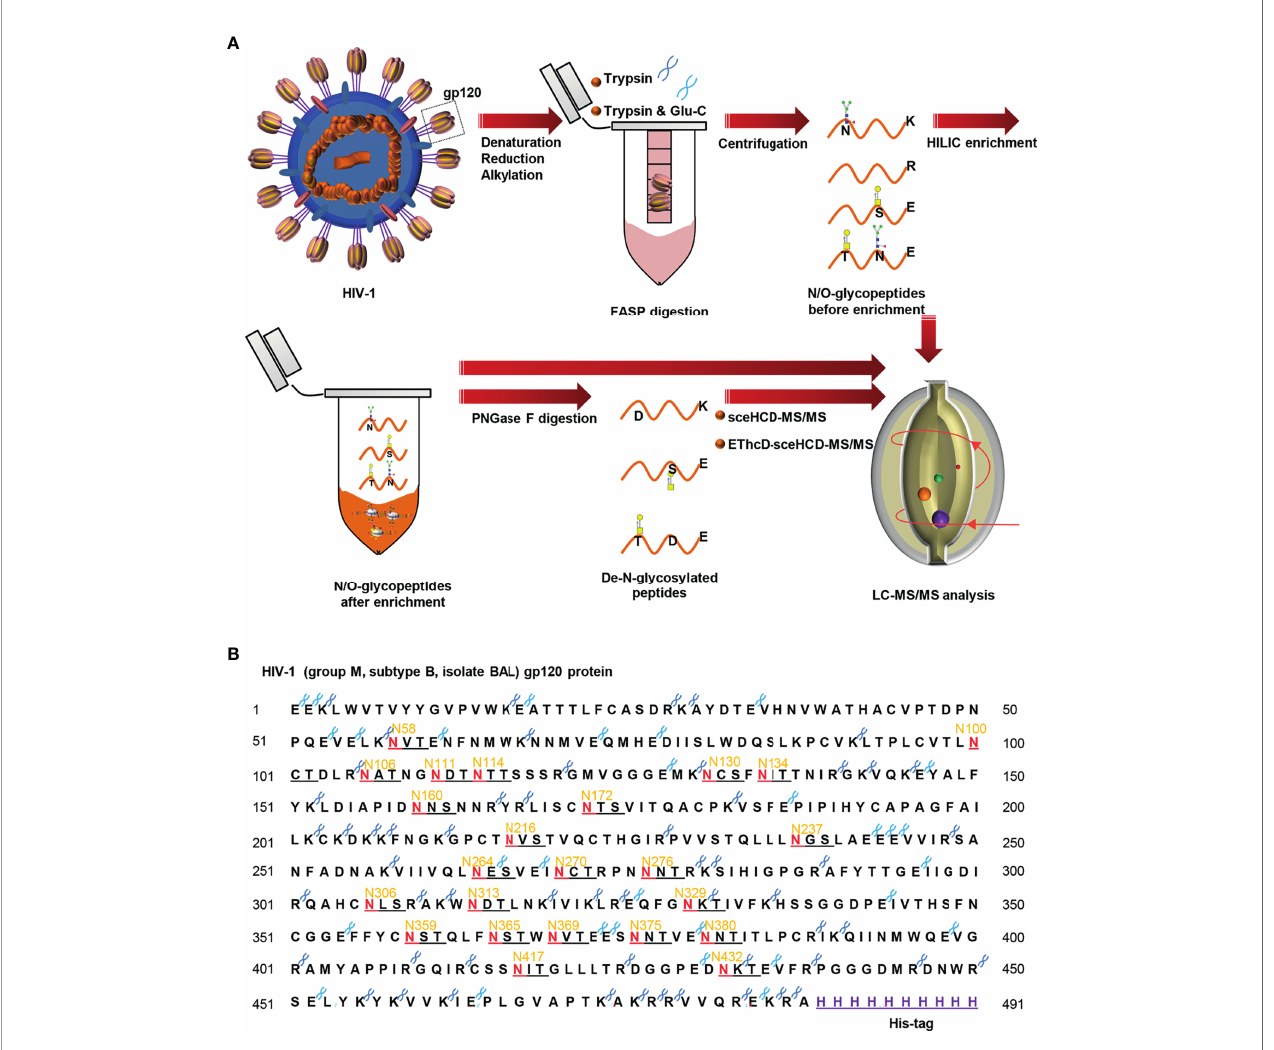
FIGURE 1 | Work fl ow for sequential N/O-glycosylation characterization of recombinant HIV-1 gp120 protein using two complementary proteases for digestion and an integrated glycoproteomic analysis using sceHCD-MS/MS and EThcD-sceHCD-MS/MS. (A) Overall experimental schematic diagram. (B) The amino acid sequence of HIV-1 gp120 protein and potential N-glycosites and enzyme cleavage sites. The dark blue and light blue “ scissors ” represent the potential digestion sites of trypsin and Glu-C respectively. The red letter “ N ” represents the potential N-linked glycosylation